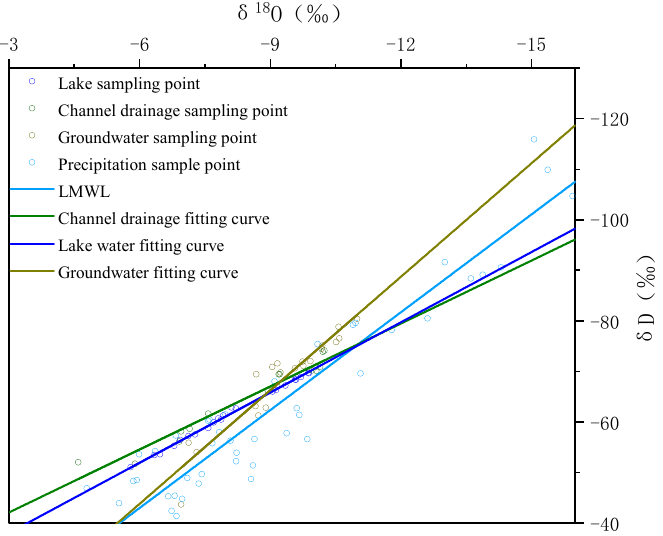
Figure 7. Relationships among δ 18 O and δ D of channel water, lake, groundwater, and local precipita- tion in the Wuliangsu Lake basin.